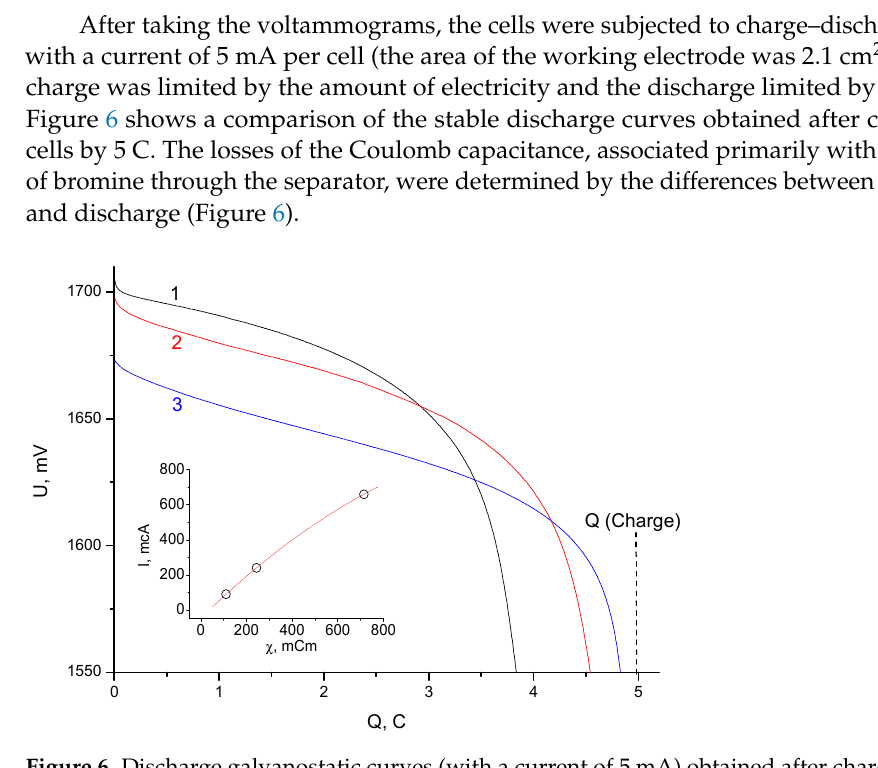
Figure 6. Discharge galvanostatic curves (with a current of 5 mA) obtained after charging the cells by 5 C for: 1—cell 1; 2—cell 2; 3—cell 3. The inset shows the dependence of the leakage current (self-discharge) on the electrical conductivity of the separator group at a frequency of 10 kHz.